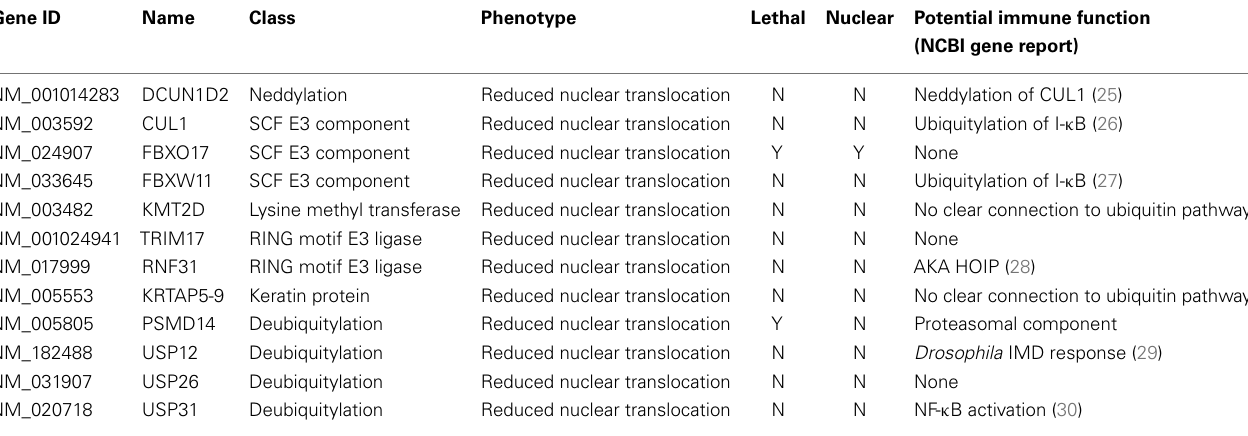
Table 1 | Ubiquitin pathway modifiers ofTNF signaling at 30min